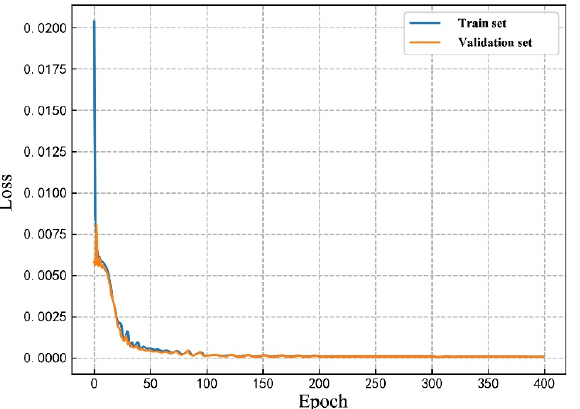
Figure 4. The deformation loss rate curve of the training set and the validation set. The loss value approaches 0 after 400 epochs.